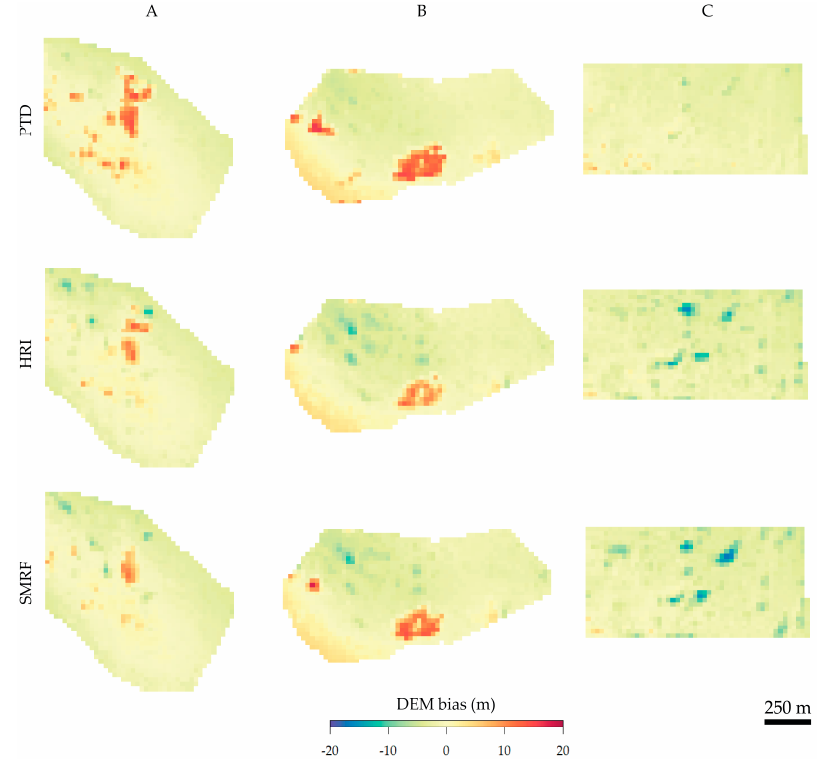
Figure 7. Spatial distribution of the ALS vs. DAP-DEM bias averaged using 25 × 25 m cells for the three study areas and ground classification methods.